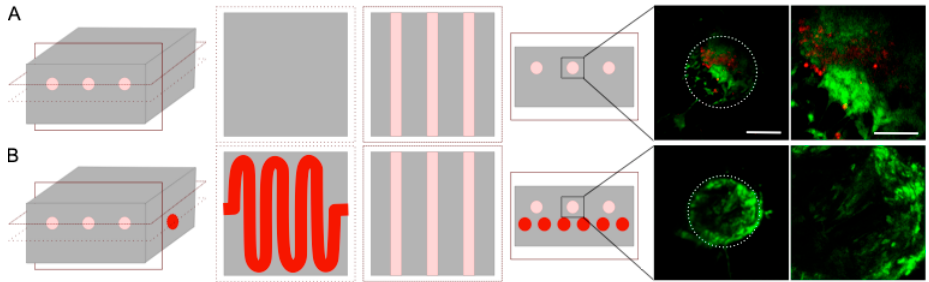
Figure 6. Live (green)/dead (red) staining after 7 days of cultivation inside collagen hydrogel without ( A ) or with ( B ) a passive perfusion channel. Slices were obtained in the middle of each construct. The white circle represents the channel walls from a side view. Scale bar: 250 and 50 µ m.